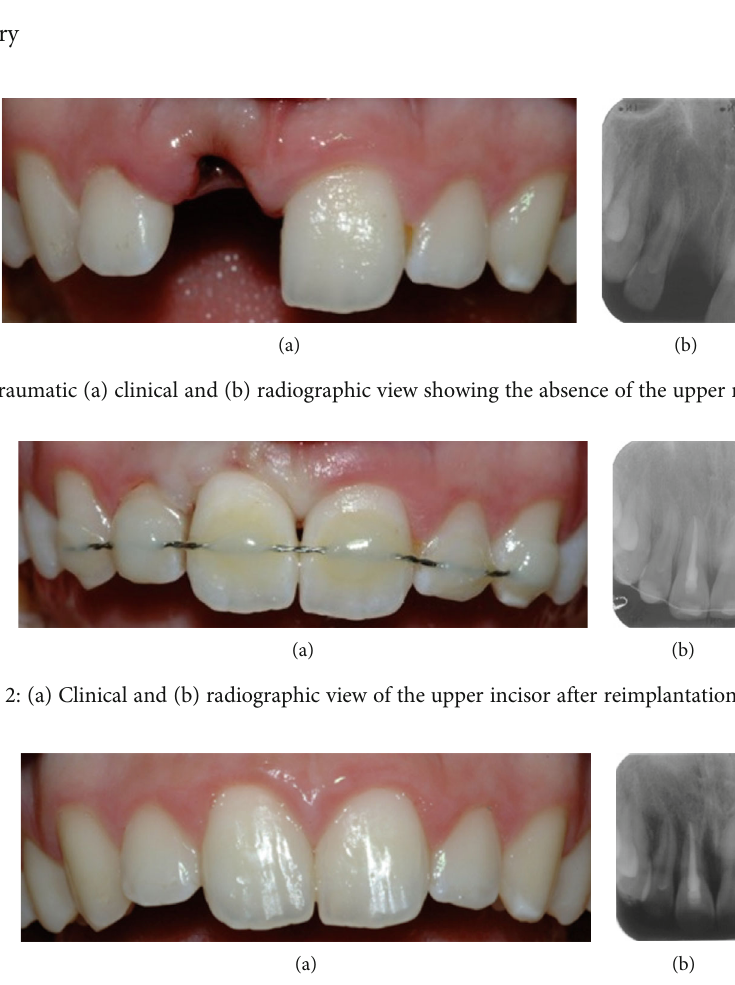
Figure 3: (a) Clinical and (b) radiographic view of the upper incisor at the 3-year follow-up visit.